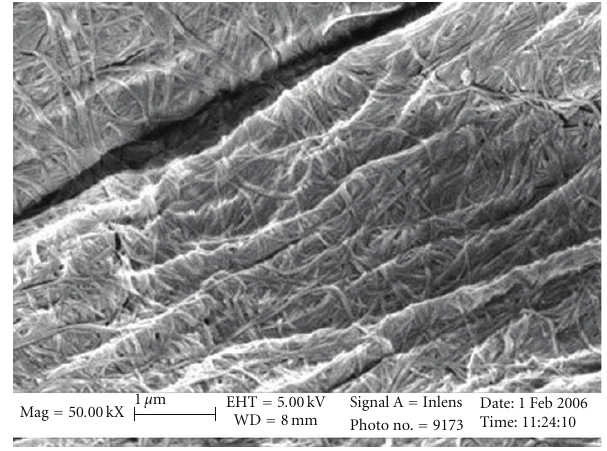
Figure 10: Hemp fiber after bacterial cellulose modification